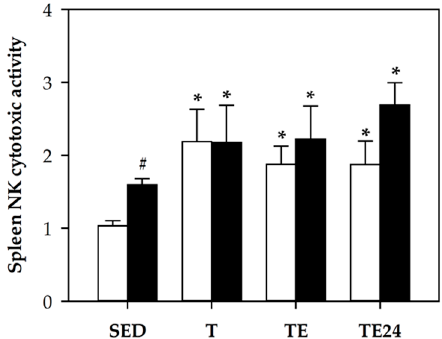
Figure 5. Spleen NK cytotoxic activity (number of dead target cells per 100 e ff ector cells). The non-supplemented groups are represented by white bars and the hesperidin-supplemented groups by black bars. SED = sedentary groups; T = trained groups; TE = T groups with an additional exhaustion test; TE24 = TE groups 24 h after the exhaustion test. Data are expressed as mean ± SEM ( n = 8). Statistical di ff erence (Mann–Whitney U test): * p < 0.05 vs. SED group; # significant di ff erences between non-supplemented and the counterpart hesperidin-supplemented group ( p < 0.05).